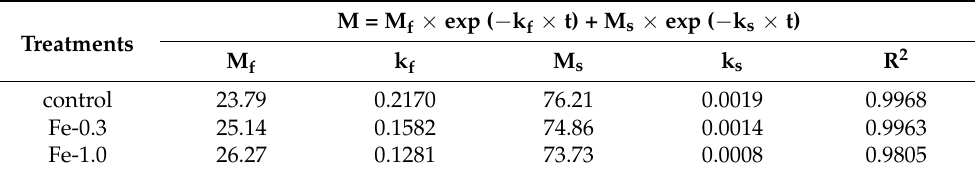
Table 1. Regression models of the maize straw mass and incubation time.